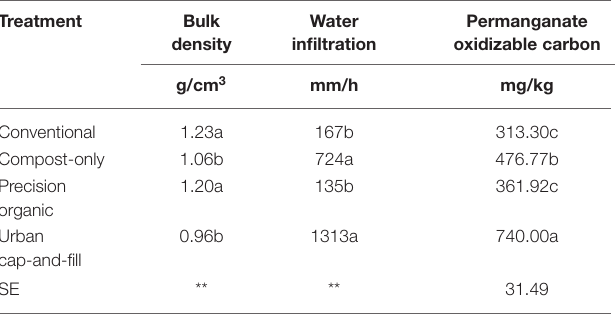
TABLE 9 | Soil physical properties and permanganate oxidizable carbon concentration after three growing seasons (October 2019).